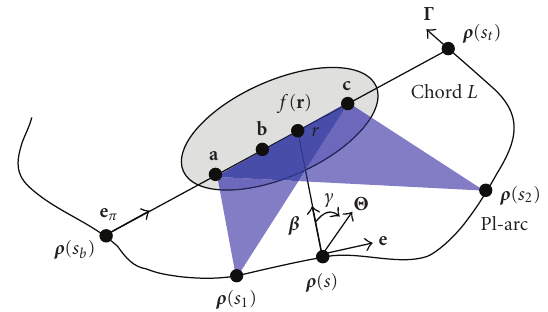
Figure 1: Basic setting for exact 3D interior reconstruction from truncated limited-angle datasets.